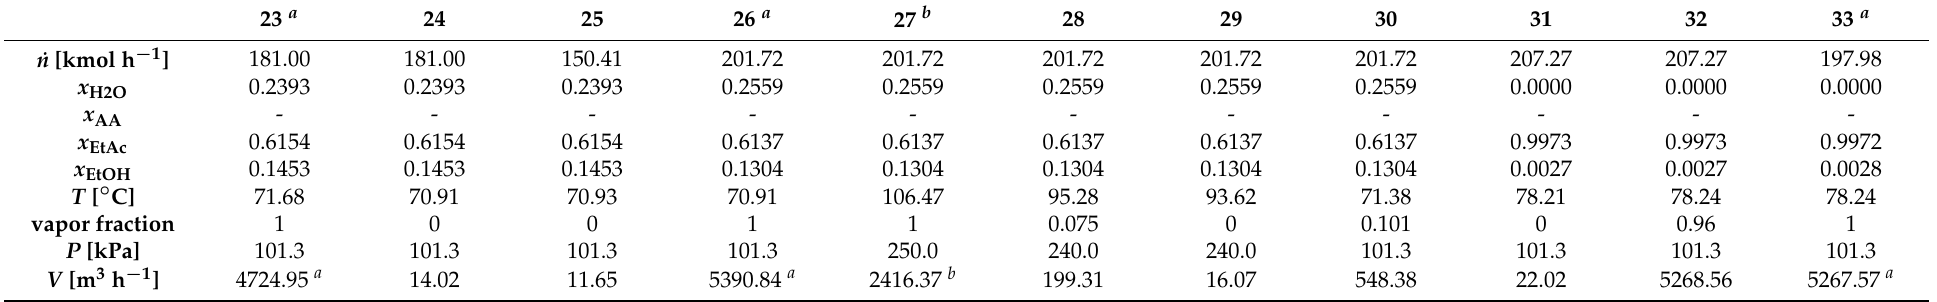
Table A4. Material balance of designed RD column with a separation unit and an MVRHP (Figure 6): heat pump subsystem.